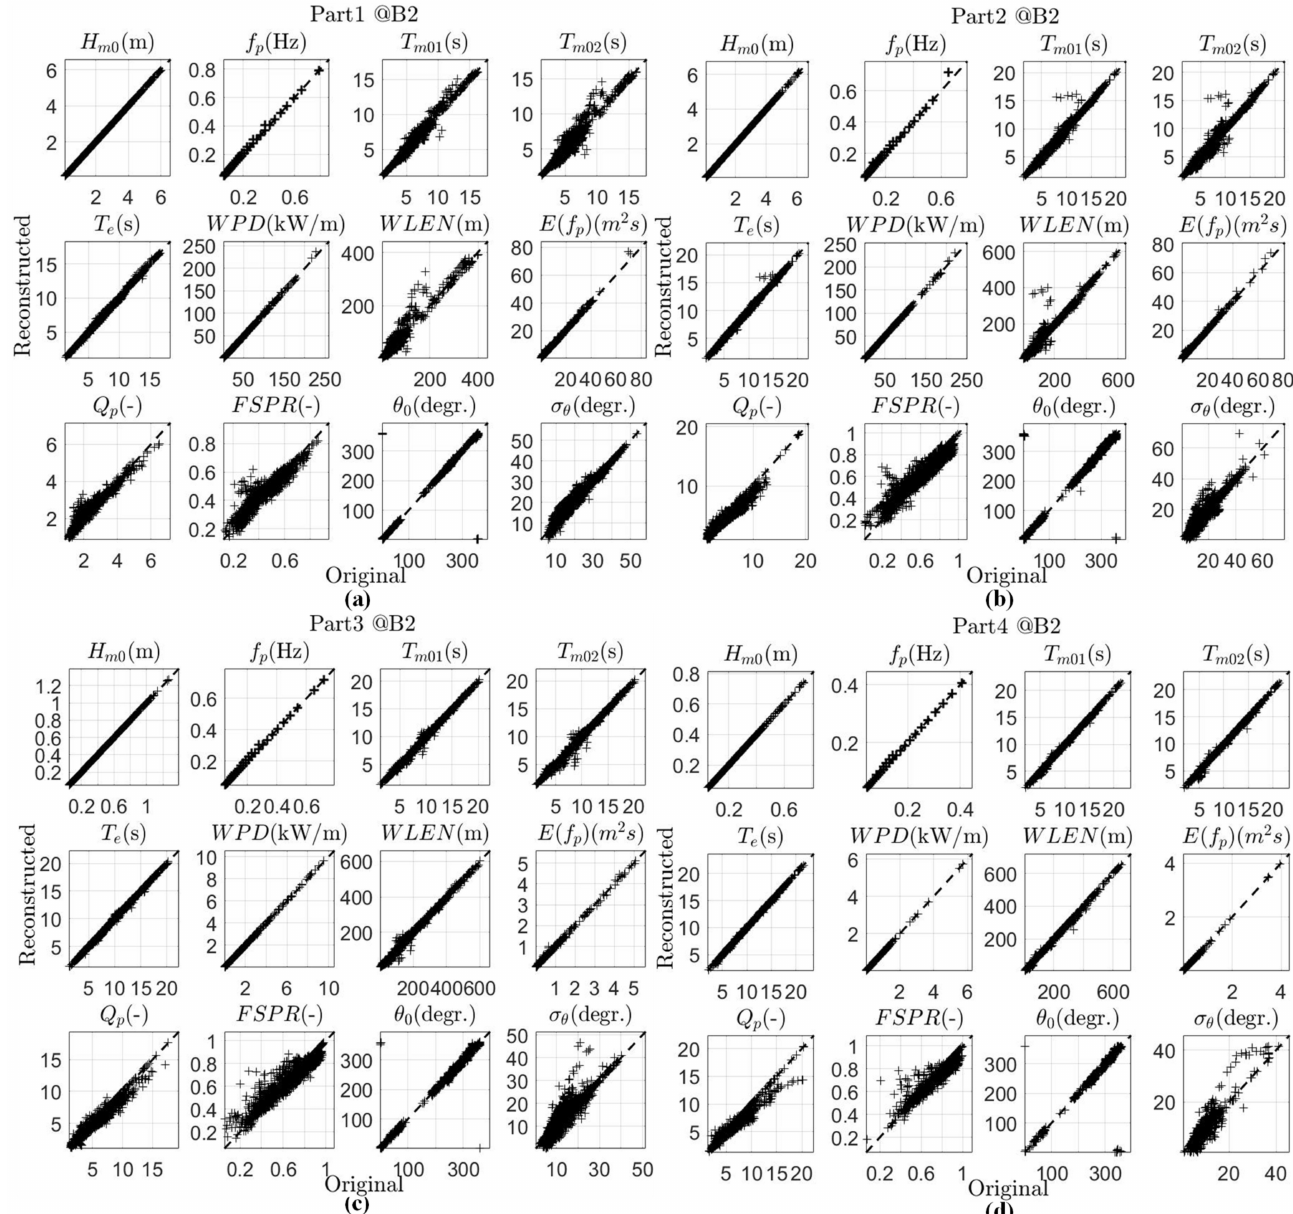
Figure 3. Scatter plots for KPs obtained from the original and the reconstructed partitions at check point B2: ( a ) Partition 1, ( b ) Partition 2, ( c ) Partition 3, and ( d ) Partition 4. The partitions from the same spectrum are ordered from large to small based on their H m 0